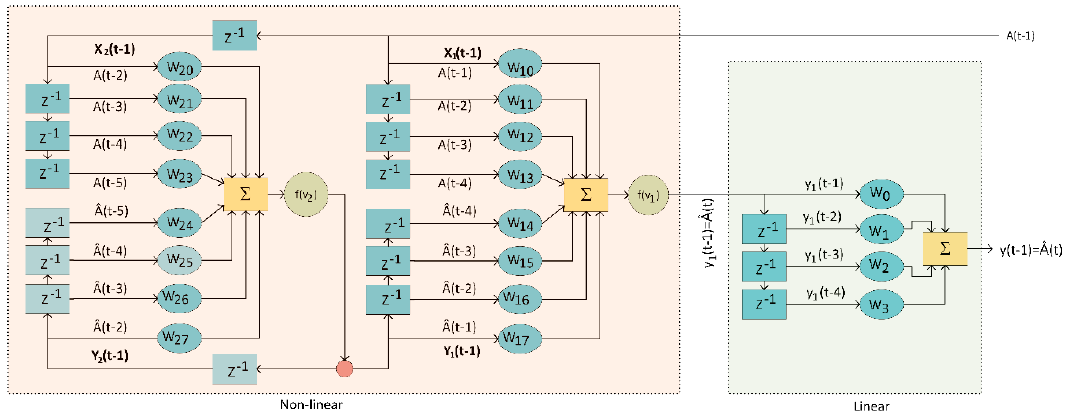
Figure 5. Adaptive Artificial neural network (AANN) to predict short-term rain attenuation.